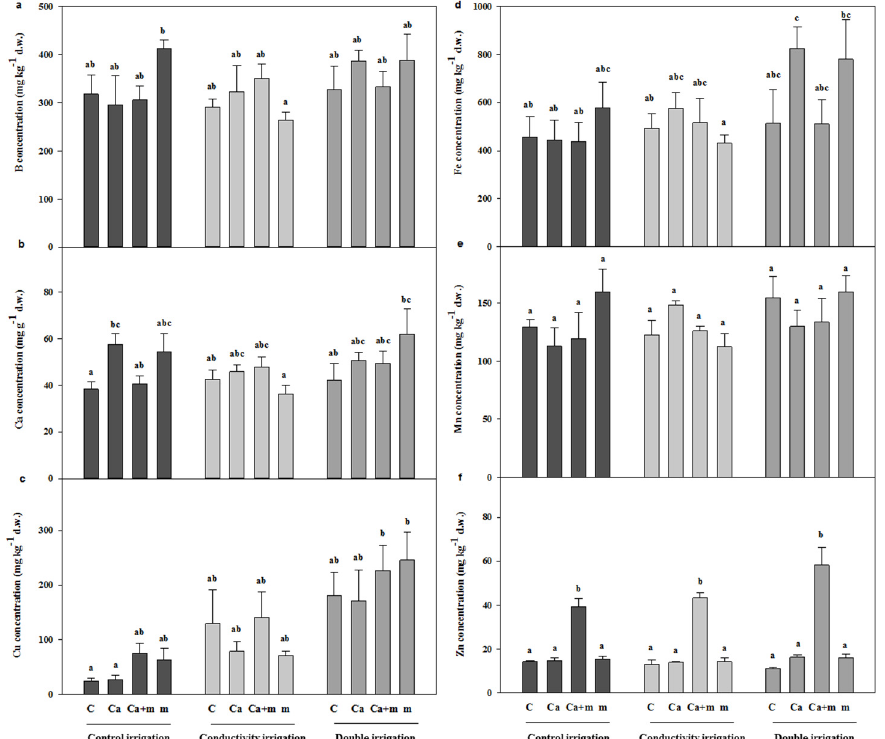
Figure 3. Leaf cation concentrations: ( a ) B (mg kg − 1 ), ( b ) Ca (mg g − 1 ), ( c ) Cu (mg kg − 1 ), ( d ) Fe (mg kg − 1 ), ( e ) Mn (mg kg − 1 ), and ( f ) Zn (mg kg − 1 ). The Mo levels were not detectable (data not shown). Statistical analysis was performed using SPSS 25.0.0.1. The values are the means ± SE of three individual analyses. Columns with di ff erent letters di ff er significantly, according to Duncan’s test ( p =